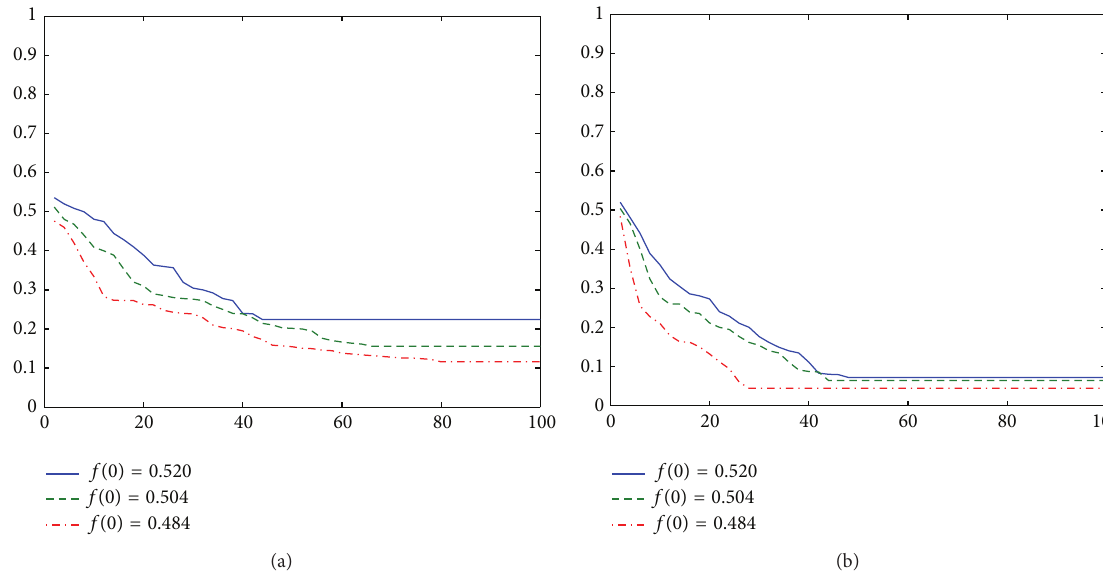
Figure 6: Simulation results on a 50×50 square lattice with von Neumann neighborhood and different random initial distributions of players. The 𝑥 -axis represents the number of generation, and 𝑦 -axis represents the frequency of cooperators in the evolution. The results in (a) and (b) are, respectively, performed by the parameters region {𝑢 1 0 > 𝑢 2 1 , 𝑢 2 0 < 𝑢 3 1 ,𝑢 3 0 < 𝑢 4 1 } and {𝑢 1 0 > 𝑢 2 1 , 𝑢 2 0 > 𝑢 3 1 ,𝑢 3 0 < 𝑢 4 1 } . 𝑓(0) means the frequency of cooperators in the random initial distribution.